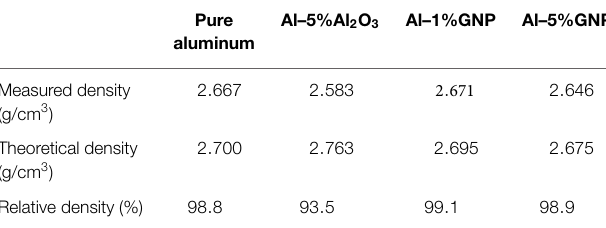
TABLE 1 | Density results of the samples after heat treatment .